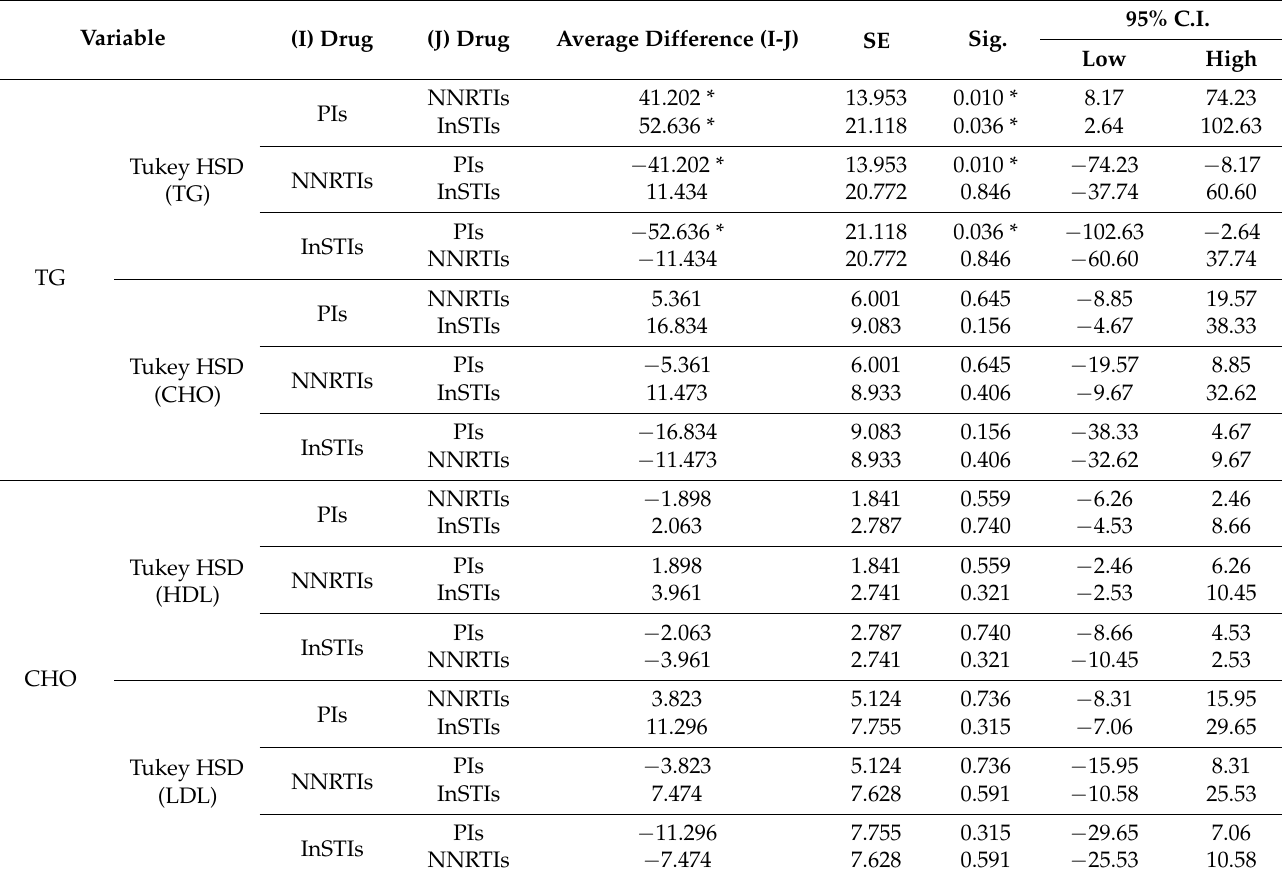
Table 6. Multiple comparison between every two HAART regimens based on lipid profiles by the Tukey honest significant difference (HSD)